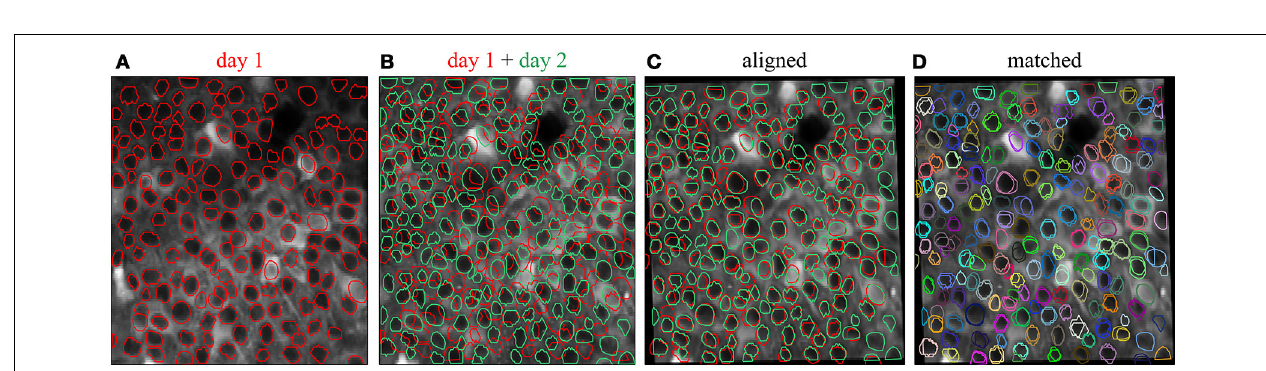
comparison. (C) Same as (B) but with an affine transformation applied to align the time-averaged image and ROIs from day 2 to those of day 1. (D) Same as (C) but with the ROIs colored by their automatically determined shared identities across both imaging